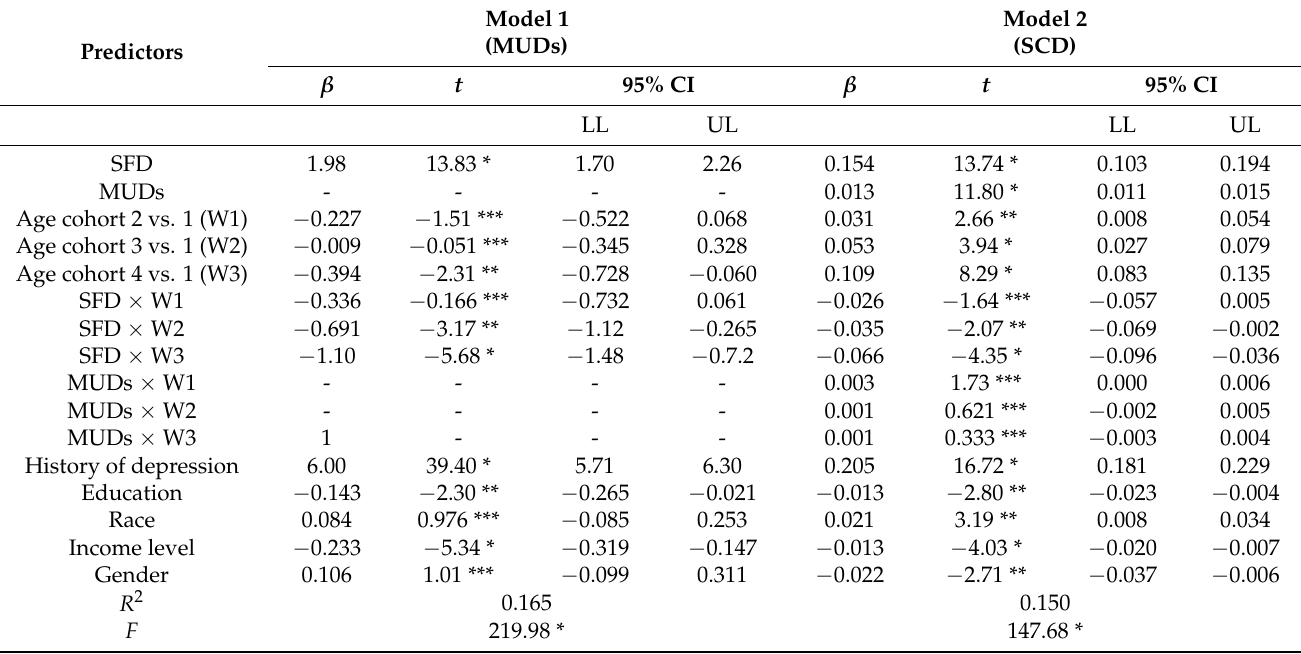
Table 4. Testing the moderated mediation effect of MUDs on SCD among older adults in the U.S., 2019.